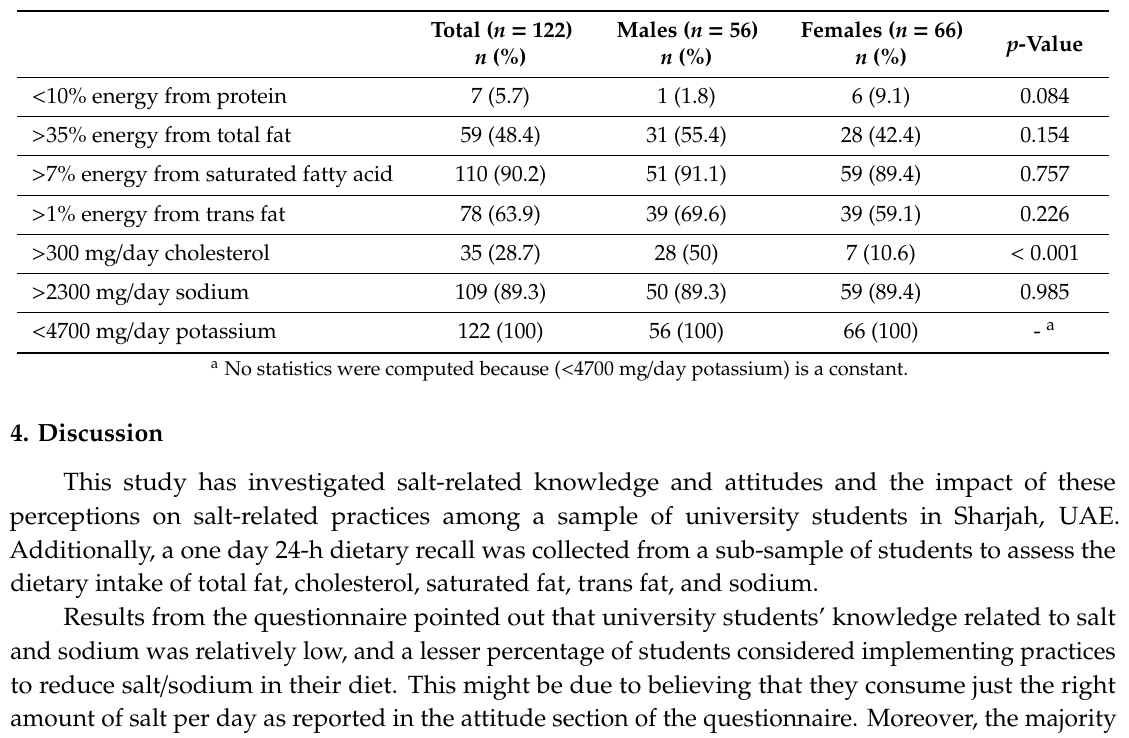
Table 7. Percentage of UOS students not meeting the dietary recommendations ( n = 122) by